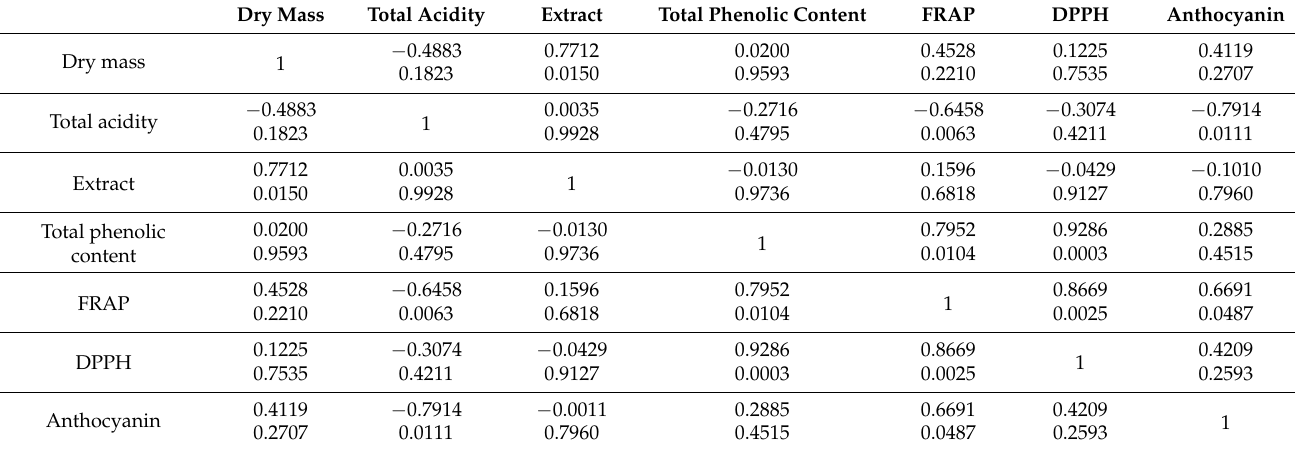
Table 5. Correlation coefficient for biologically active compounds in the ‘Einset Seedless’ raisins and their